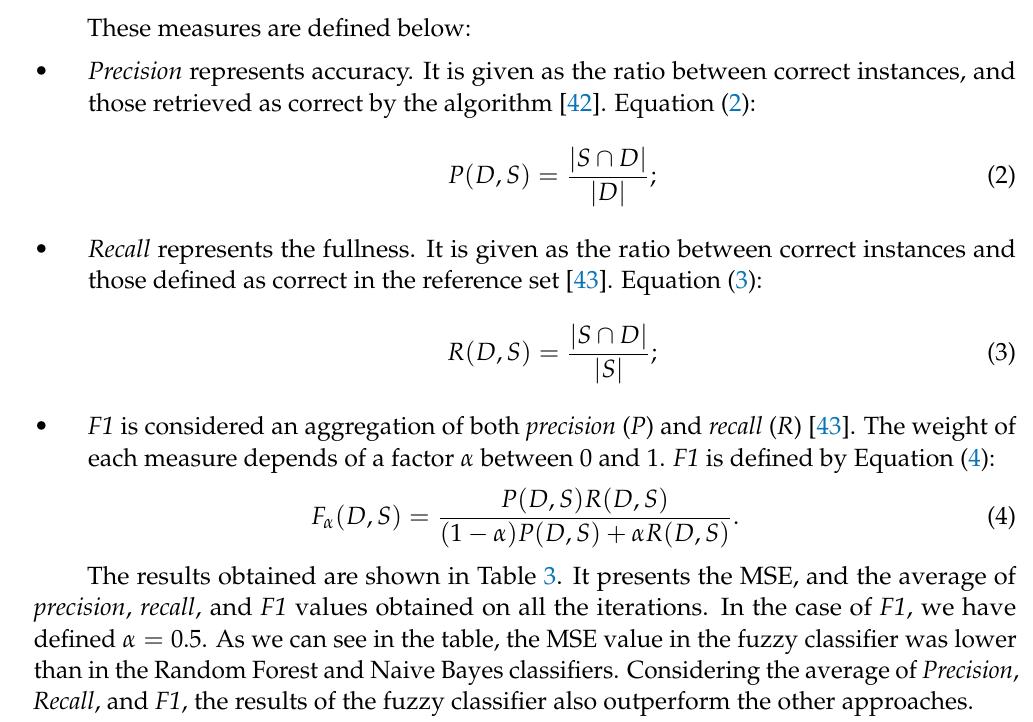
Figure 6. Parameters involved in Precision and Recall computation.